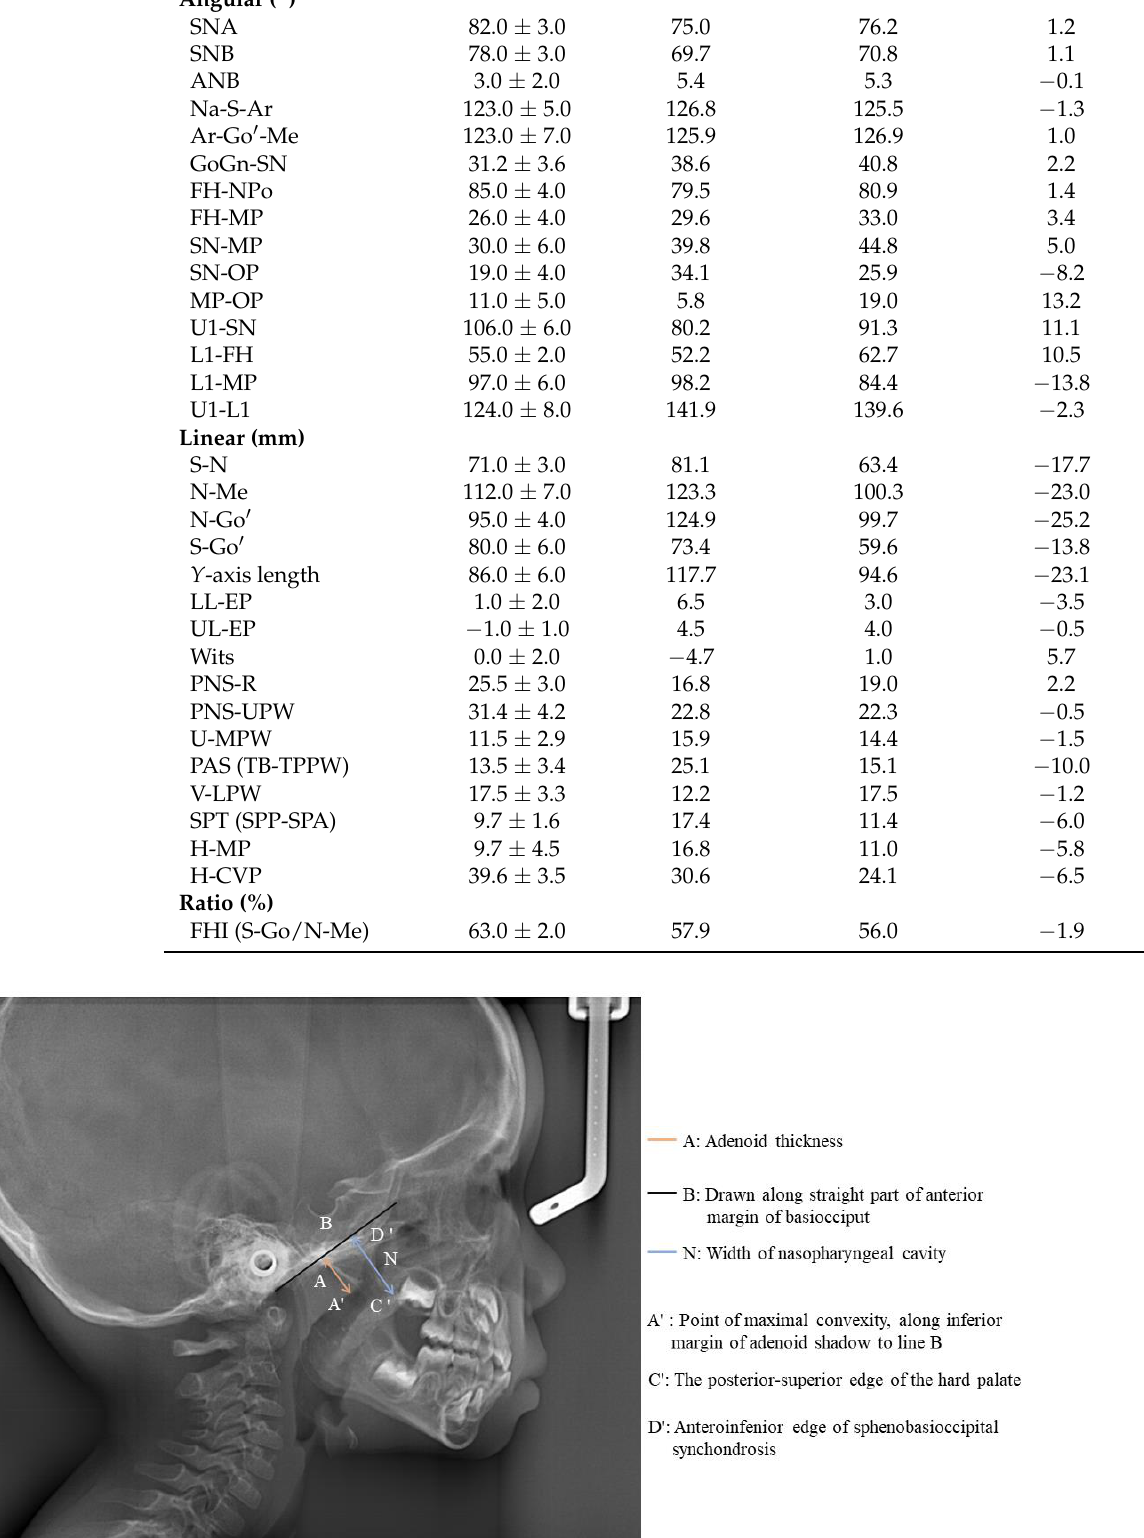
Figure 5. Measurement of adenoid thickness.